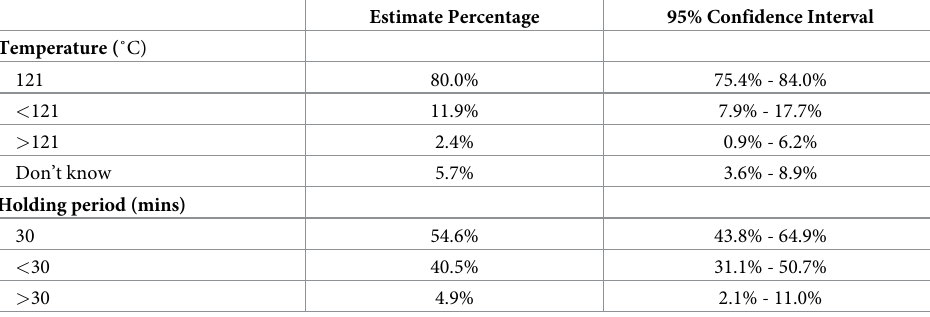
Table 4. Temperature and holding period of autoclave cycles as stated by the